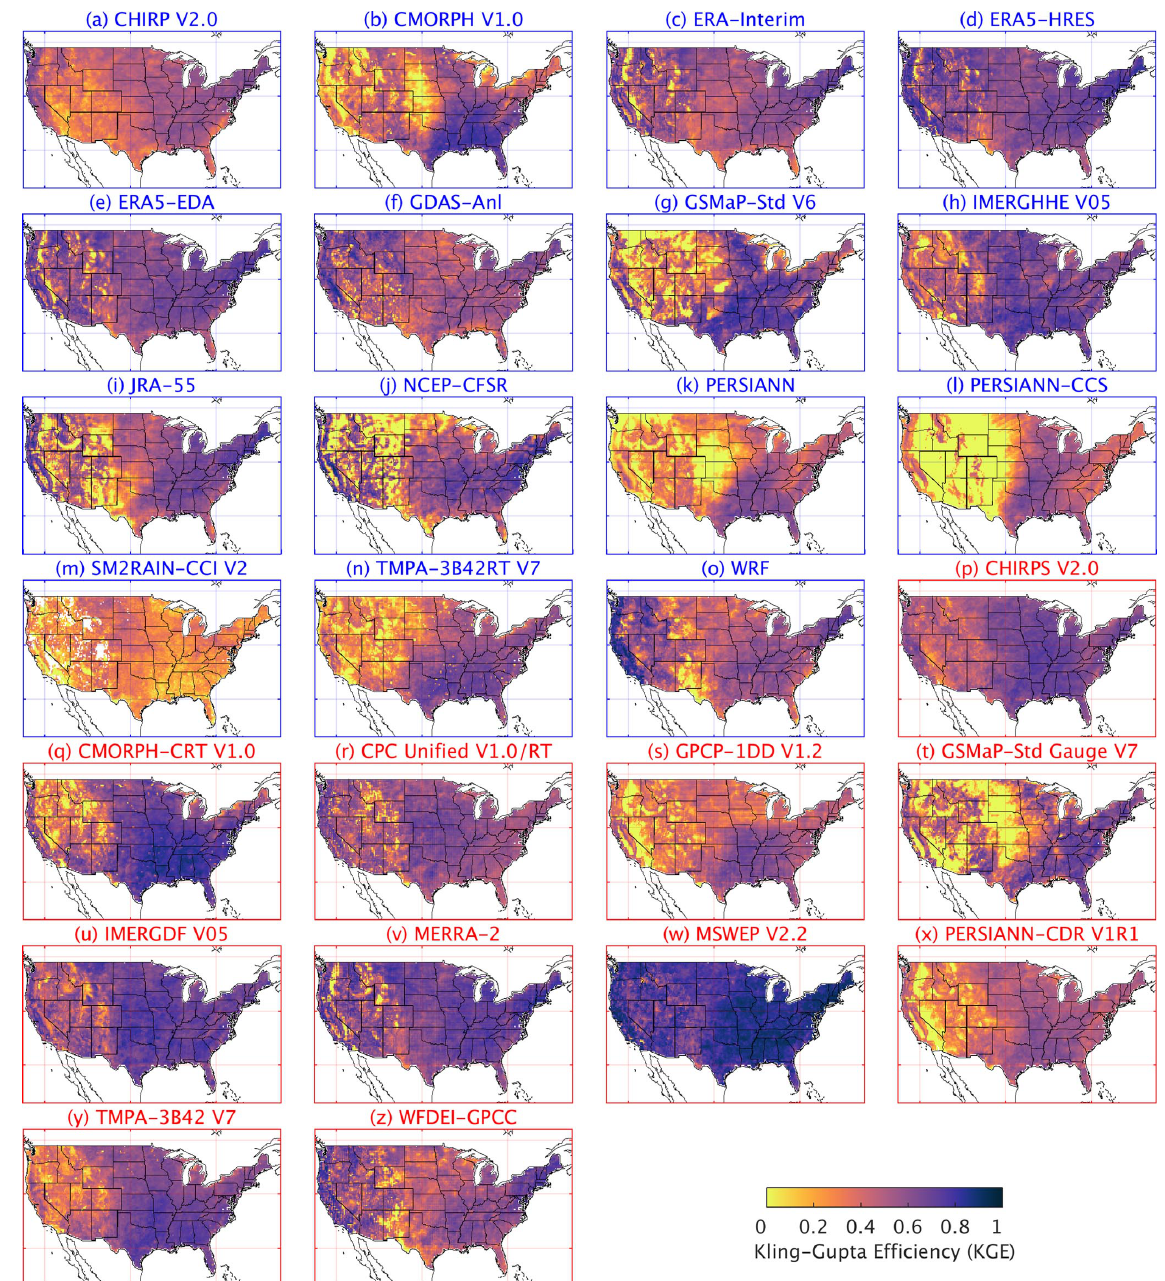
Figure 1. KGE scores for the 26 gridded P datasets using the Stage-IV gauge-radar dataset as a reference. White indicates missing data. Higher KGE values correspond to better performance. Uncorrected datasets are listed in blue, whereas gauge-corrected datasets are listed in red. Details on the datasets are provided in Tables 1 and 2. Maps for the correlation, bias, and variability components of the KGE are presented in the